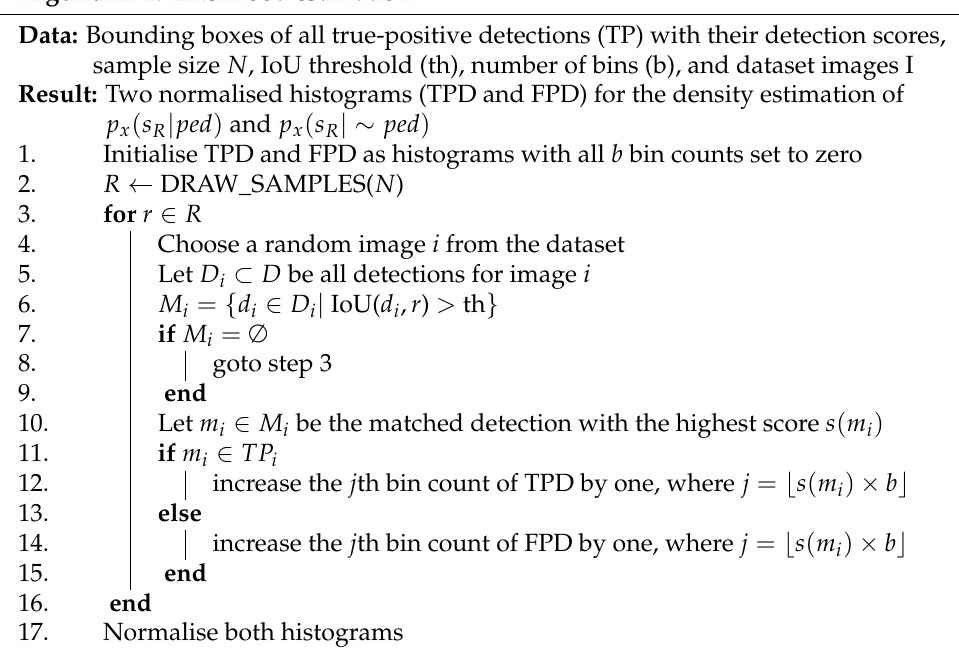
Algorithm 2: Likelihood